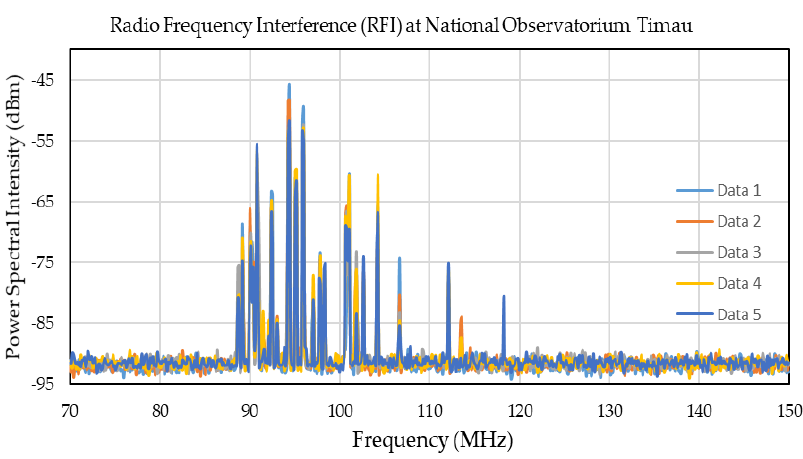
Figure 3. Results of a radio frequency survey at low frequencies between 70 and 150 MHz.